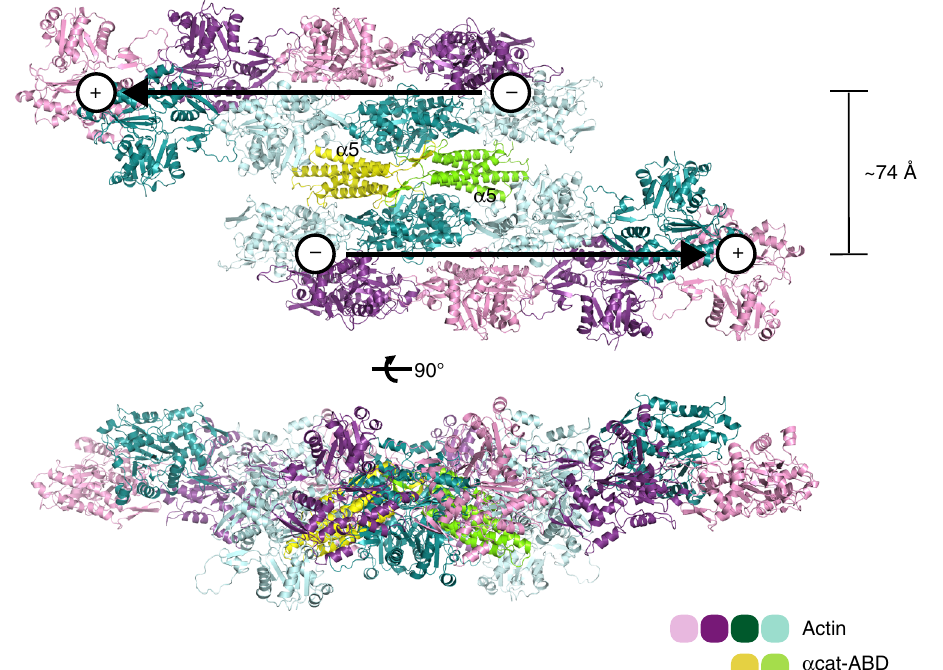
Fig. 8 A molecular model of the α cat-ABD homodimer facilitating actin bundling. The α cat-ABD/F-actin complex model based on the vin-ABD/F-actin cryo-EM structure suggests that two α cat-ABD molecules discretely bound to different actin fi laments (e.g., α cat-ABD binds to F-actin through the α 5- helix) can homodimerize through the crystallographically-identi fi ed ABD-dimer interface without causing any steric clash with actin fi laments. We propose that the ABD-dependent dimerization of α -catenin facilitates actin bundling in an anti-parallel manner ( ‘ + ’ and ‘ - ’ indicate the barbed and pointed ends, respectively). The tight spacing of actin fi laments (7~8 nm) in our atomic model is consistent with the inter- fi lament distances observed within the actin rods formed by ABD*-expressing cells (Supplementary Fig.